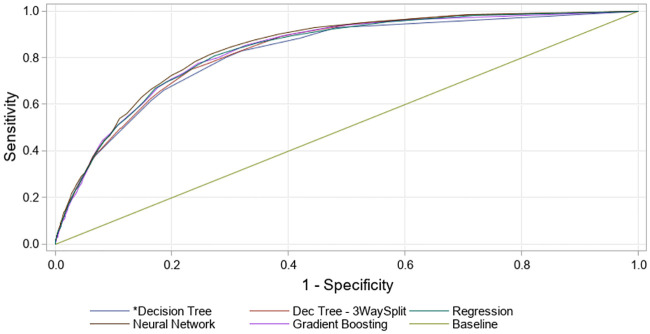
Receiver Operating Characteristic (ROC) curves for the machine learning models.